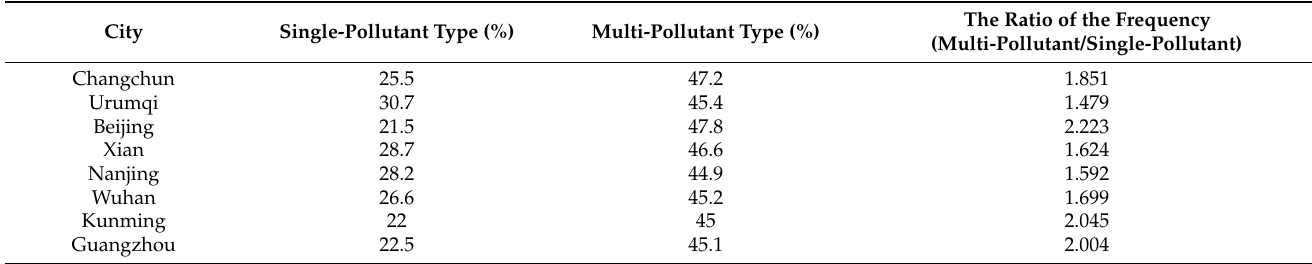
Table 3. Percentage and ratio of the frequency of multi-pollutant and single-pollutant types.